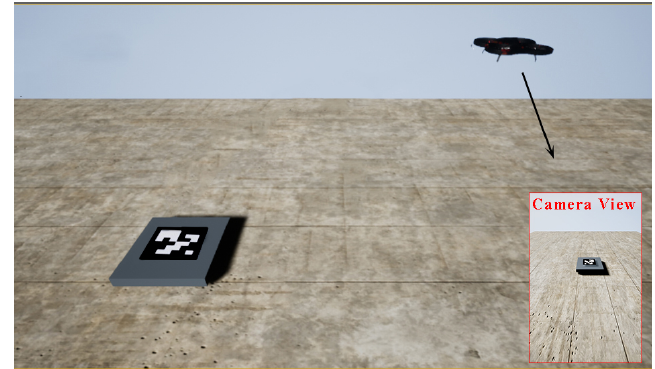
Figure 9. Simulation environment based on Microsoft AirSim.